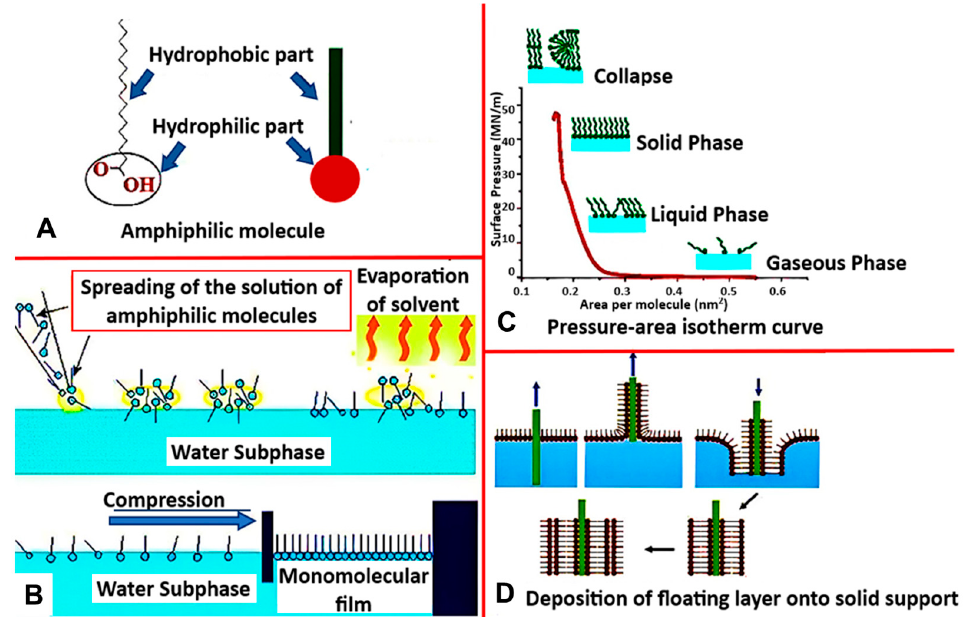
Figure 3. ( A ) Structure of amphiphilic molecule with hydrophobic and hydrophilic parts, ( B ) Langmuir Blodget process ( C ) Isotherm curve representing thermodynamic behavior of Langmuir-monolayer ( D ) Method of deposition of floating layer on to a solid support. [reproduced with permission from Hussain et al. [67], copyright 2018 Cell Press]